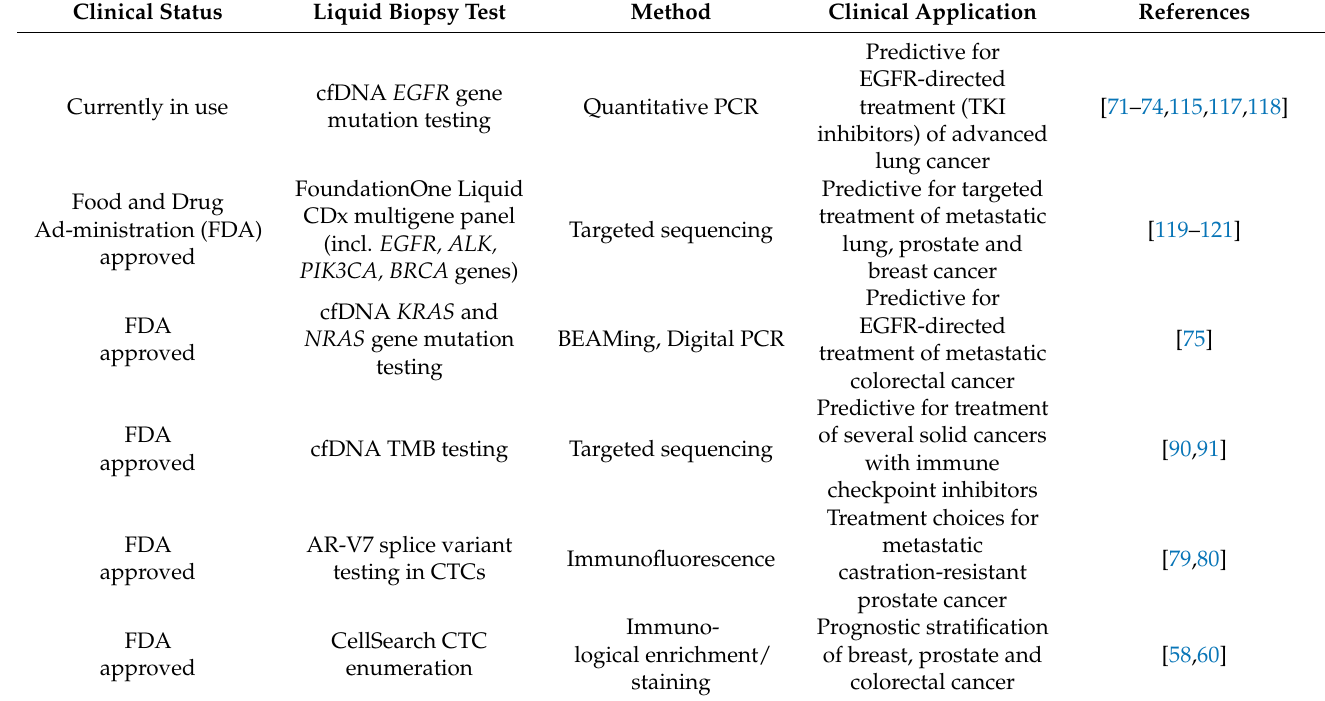
Table 3. Liquid biopsy applications currently in use or near use in Nordic clinical practice.